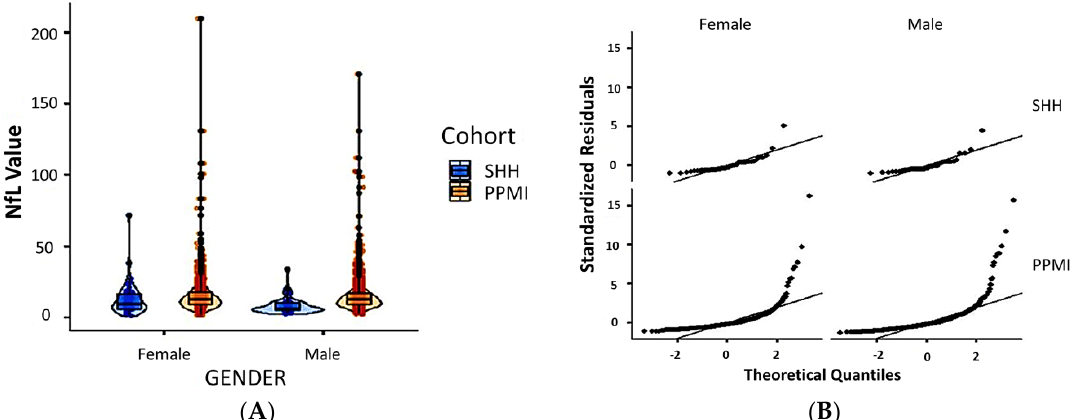
Figure 1. ( A ) Violin plot with imbedded boxplots showing the gender-stratified blood NfL value in the SHH and PPMI cohorts. ( B ) Graphical representation of the standardized residuals vs. theoretical quantiles of blood NfL values in females or males from the SHH and PPMI cohorts. SHH, Shuang Ho Hospital; PPMI, Parkinson’s Progression Markers Initiative.